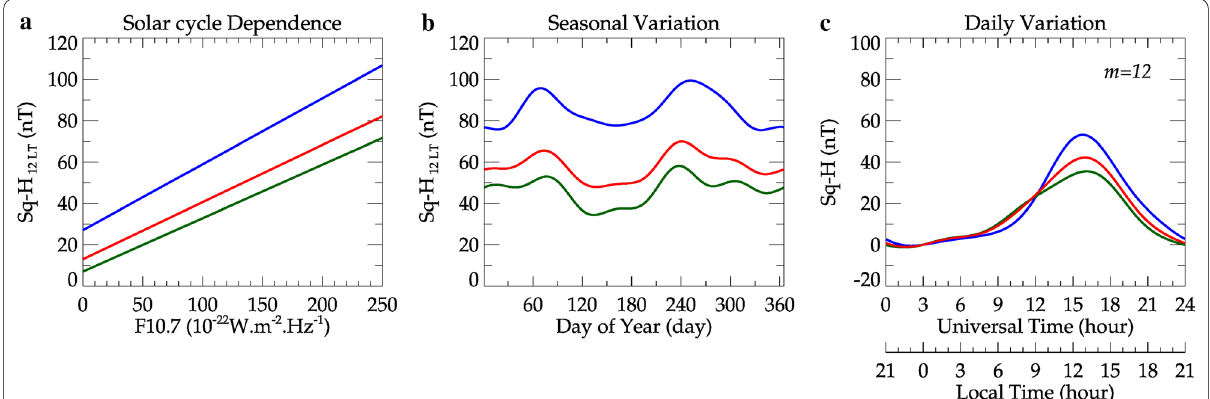
Fig. 2 Interpolated parameters obtained for MED (red), based on CBA (blue) and SMS (green) parameters. a Solar cycle parameter. b Seasonal variation parameter. c Daily variation parameter for December ( m =